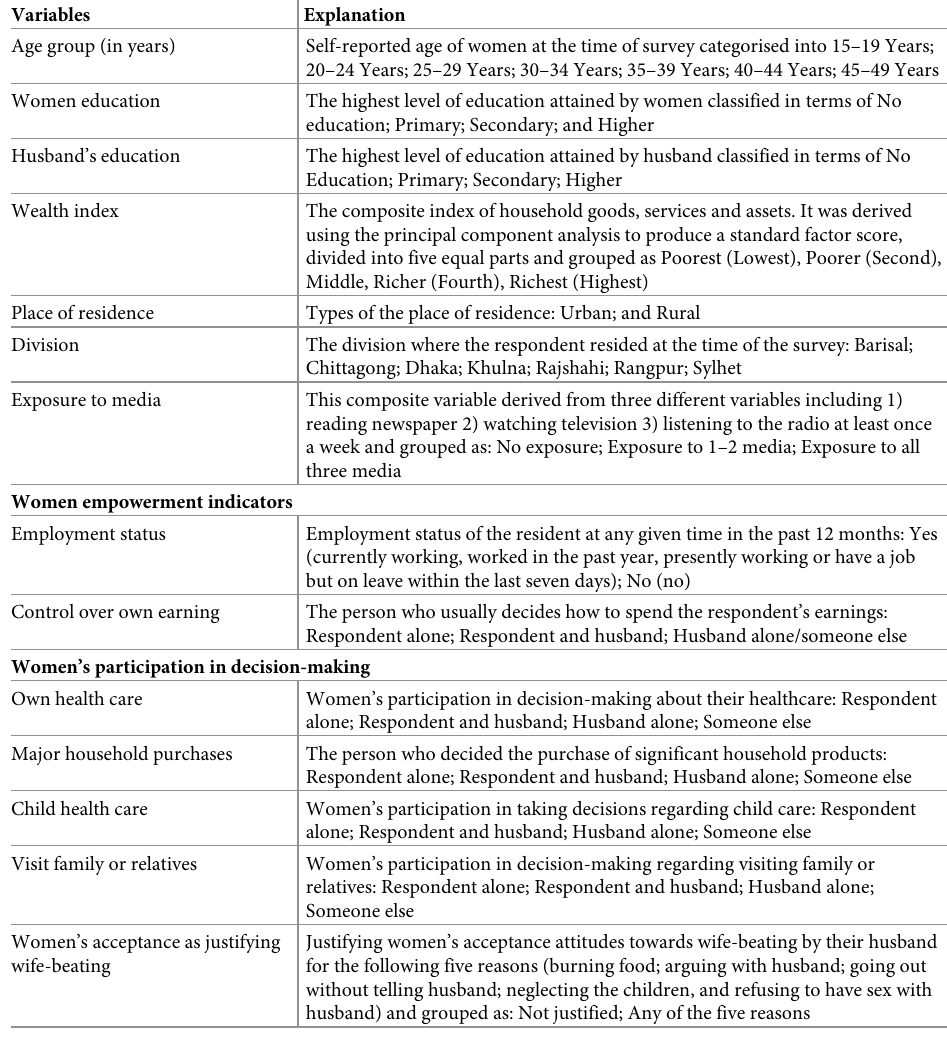
Table 2. Explanation of explanatory